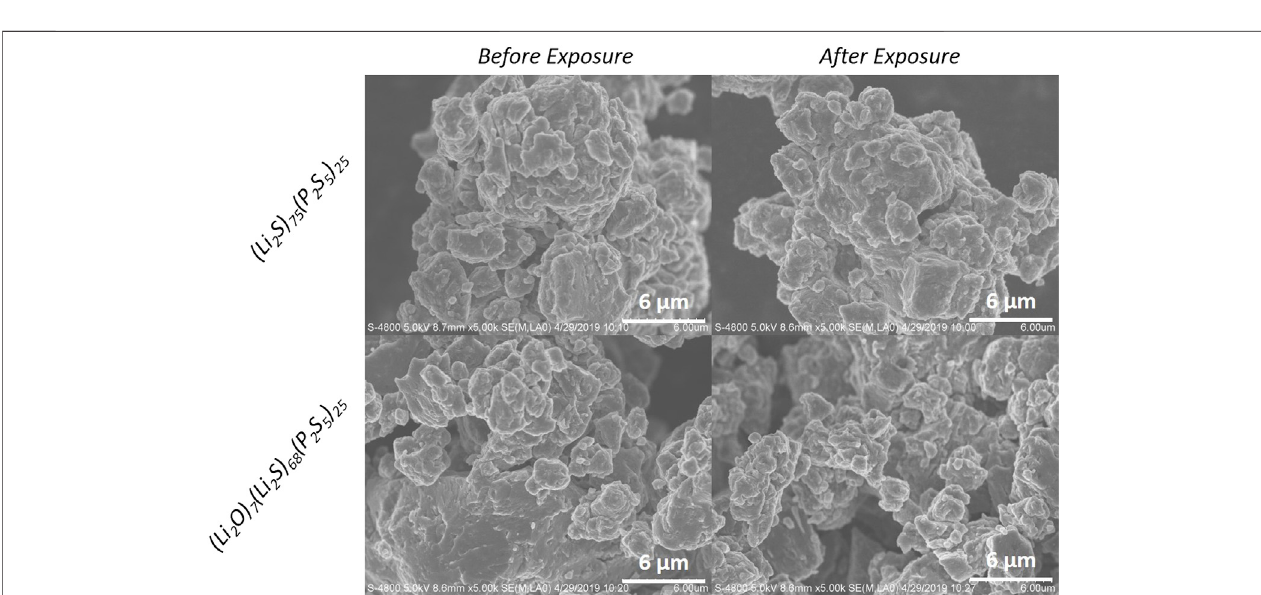
FIGURE 4 | SEM images of 75-25 LPS and 7-68-25 LPSO sul fi de SSEs before and after exposure.